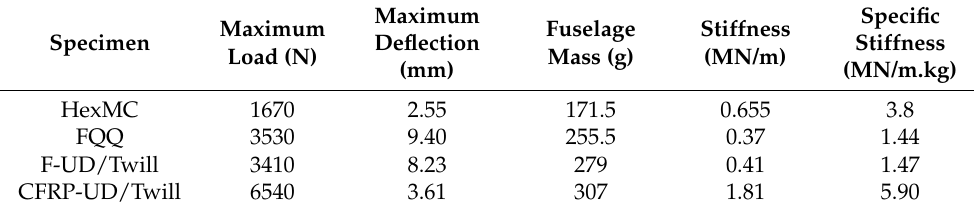
Table 7. Maximum load, deflection and stiffness of four fuselages.